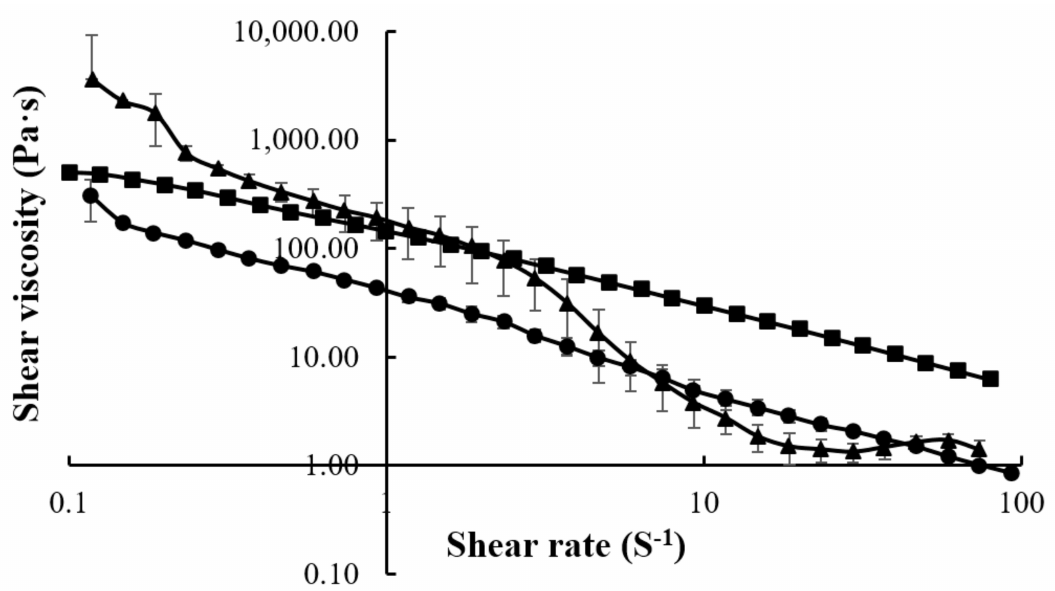
Figure 3. Flow curves of the gels prepared from ( (cid:4) ) 4% carboxymethyl cellulose (CMC), ( • ) 5% low molecular weight chitosan (LMCS), and ( (cid:78) ) 6.25% high molecular weight chitosan (HMCS).